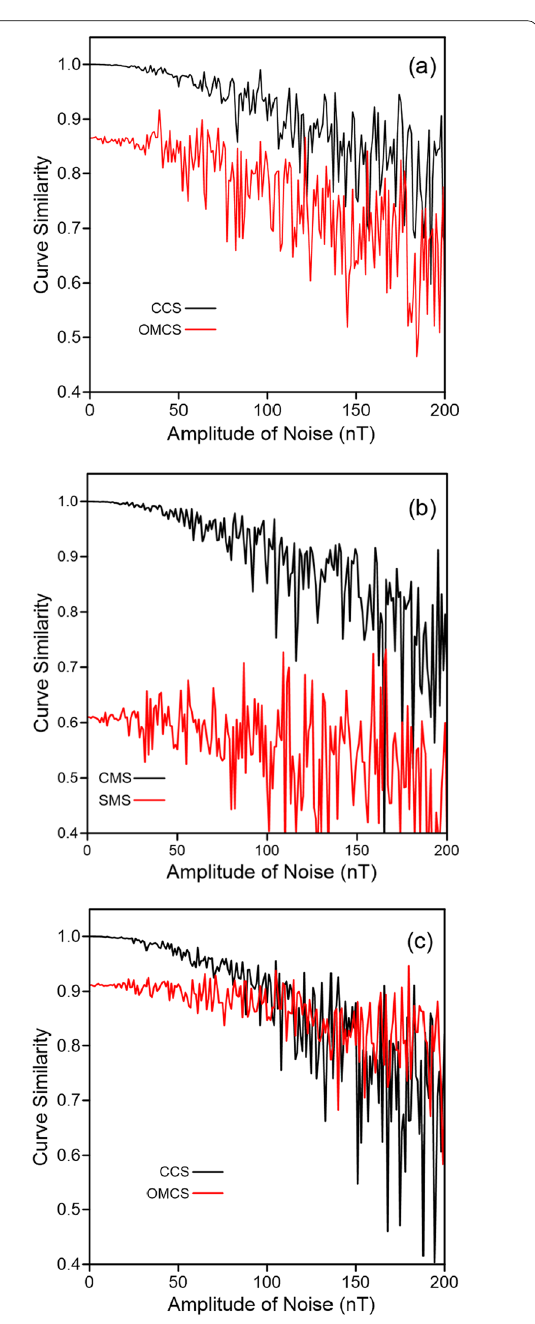
Fig. 13 The identification results of the polarity chron C27-29 with different amplitude of random noises. a The identification results of the polarity chron C27. b The identification results of the polarity chron C28. c The identification results of the polarity chron C29. The black lines represent the curve similarity between the theoretical window and the observed magnetic anomalies at the position of the corresponding steps (CCS). The red lines represent the maximum absolute curve similarity values between the theoretical window and the observed magnetic anomalies at the position outside of the corresponding steps